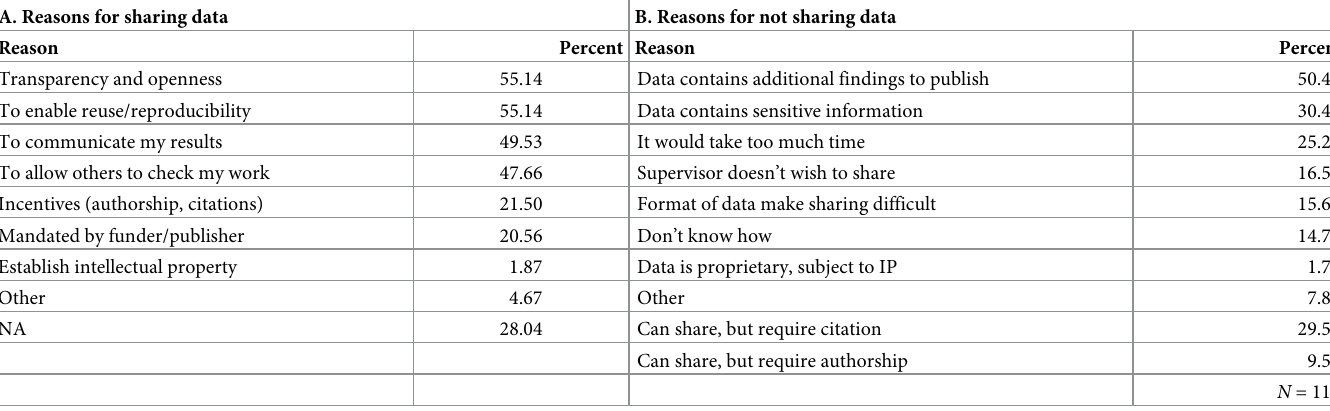
Table 5. Reasons why data can and cannot be shared.